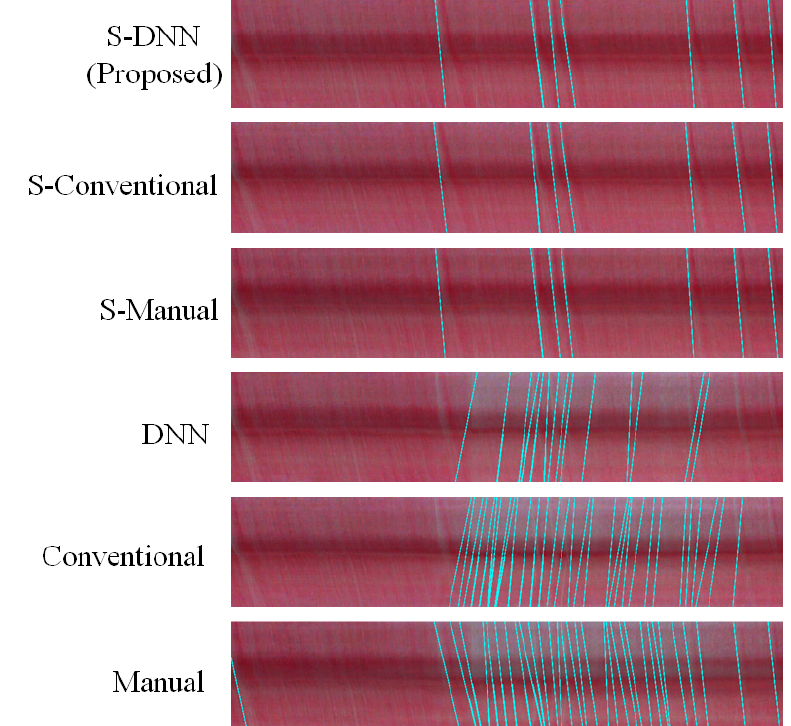
Figure A4. Events reconstructed from event counting using various methods for capillary 4 (same as Figure